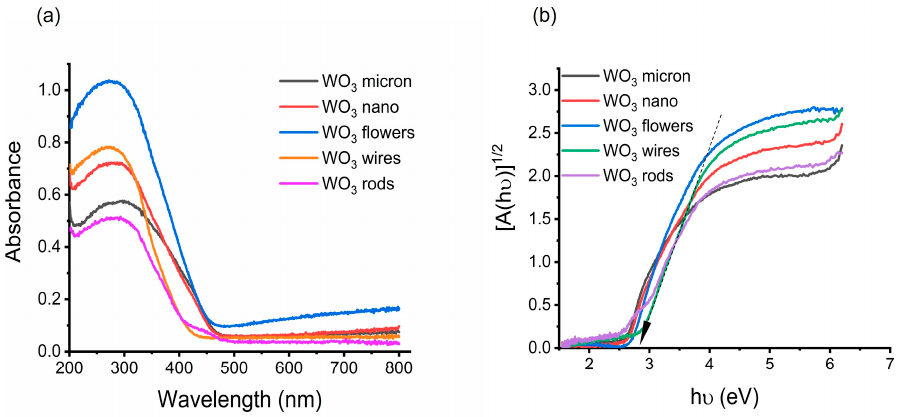
Figure 2. ( a ) Diffuse reflectance spectra of WO 3 particles ( b ) Kubelka–Munk-treated plots of WO 3